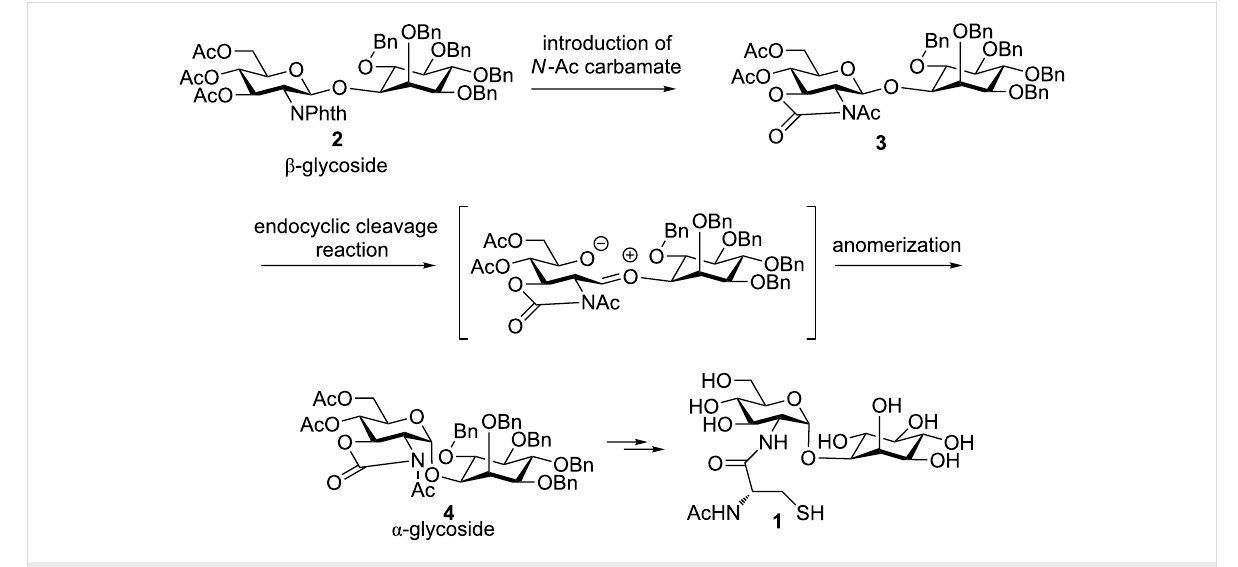
Scheme 3: Outline of mycothiol synthesis by